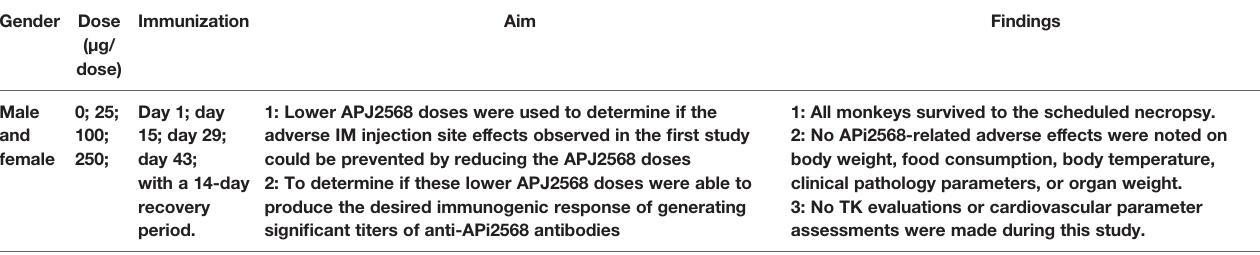
TABLE 4 | Second-set monkey study (APi2568) IMU-201 administered IM as PD1-Vaxx. Gender Dose